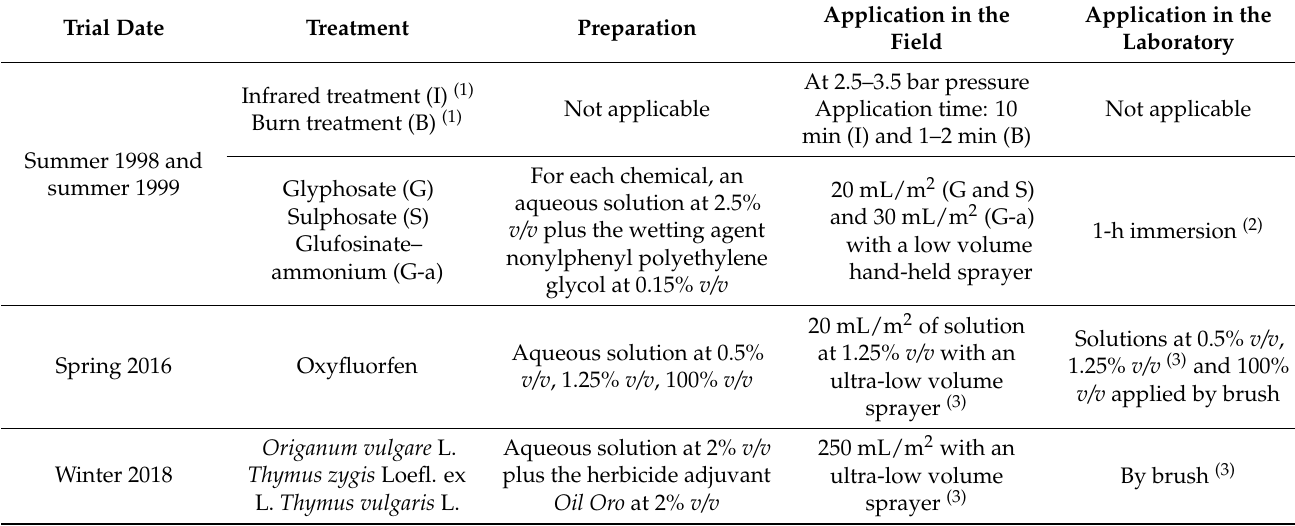
Table 1. Summary of the experimental field and laboratory trials with herbicide